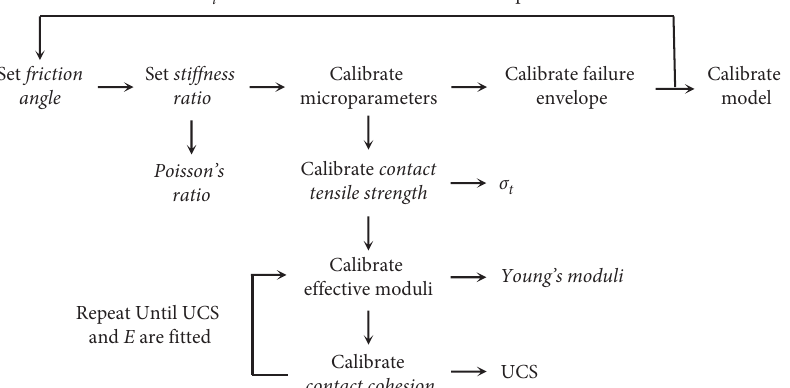
Figure 2: Uniaxial compression calibration procedure